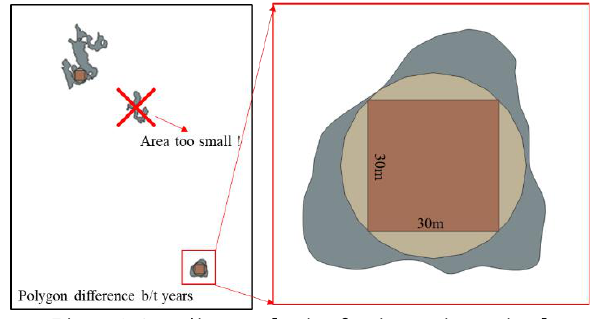
Figure 4. Coordinates selection for time series retrieval